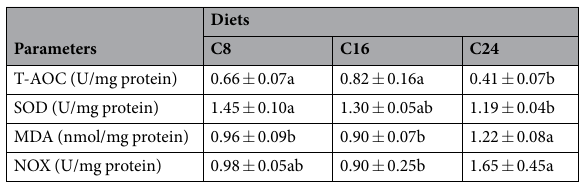
Table 4. Anti-oxidative parameters in liver of Japanese flounder after the 10-week feeding trial. Values are presented as mean ± S.D., n = 3 (8 fish/replicate). Values followed by different letters in the same row are significantly different ( P <